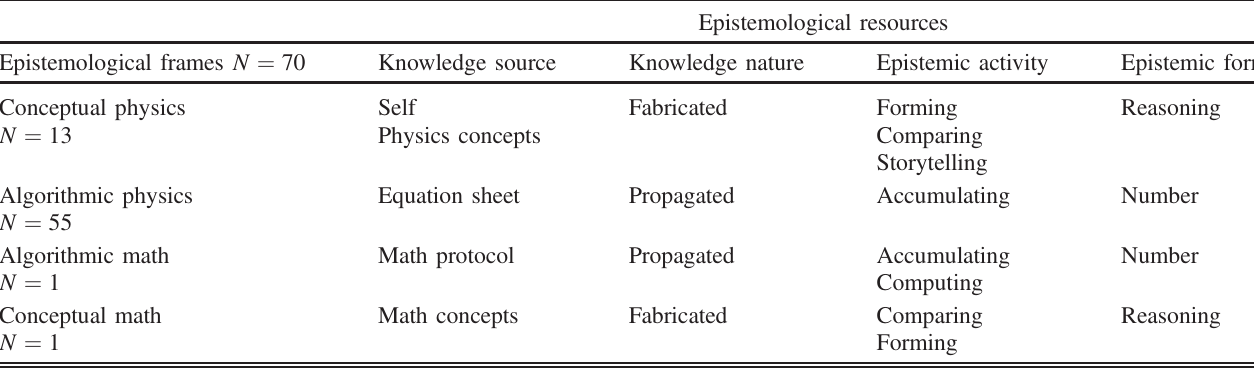
TABLE II. Total instances of each frame observed and the resources associated with them.